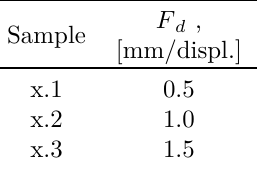
Table 3. Parameters of grinding by diamond disc.